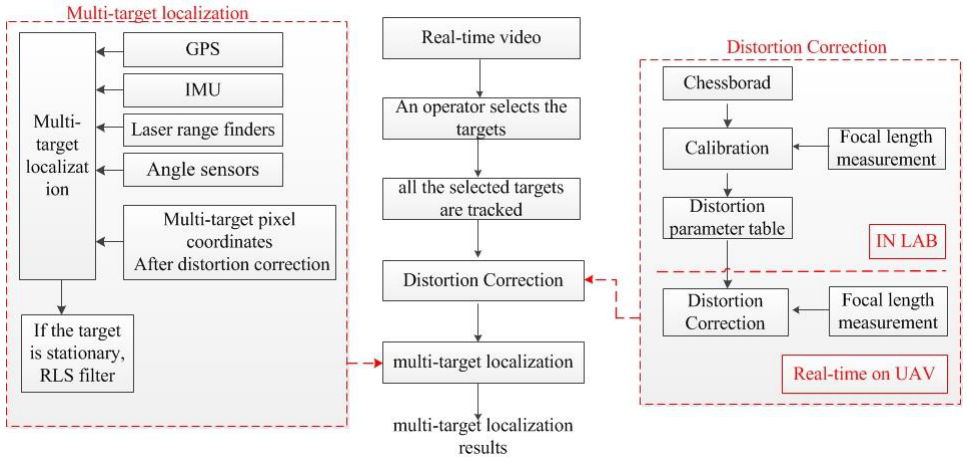
Figure 3. The overall framework of the multi-target geo-location method.